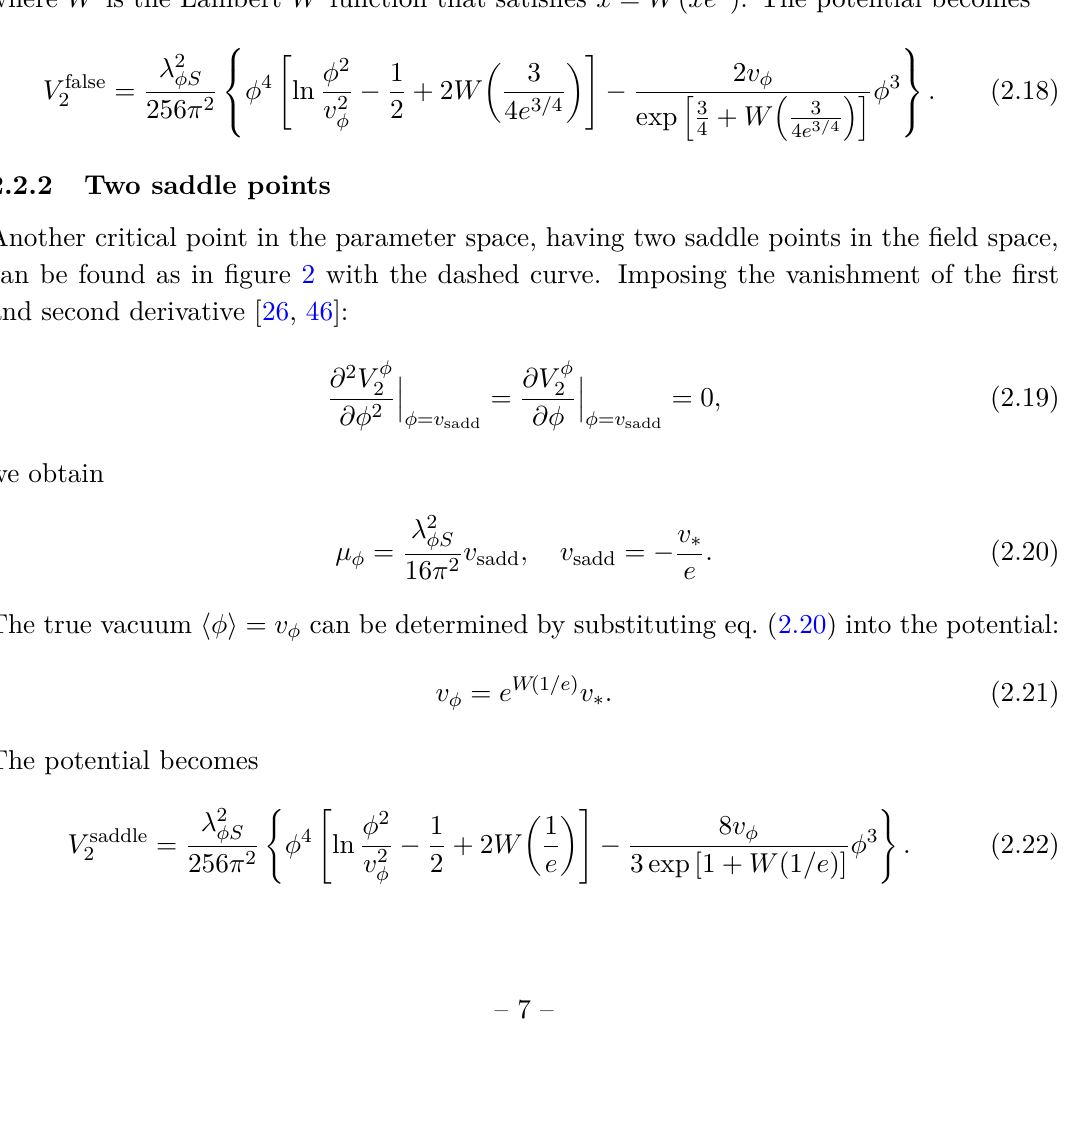
is determined φ